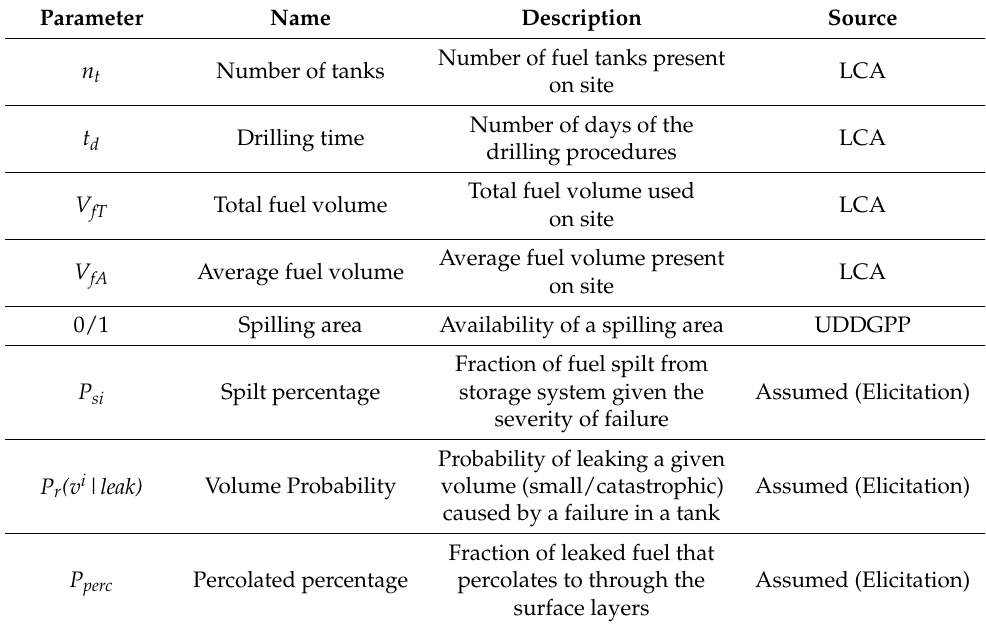
Table A1. Operational Parameters.